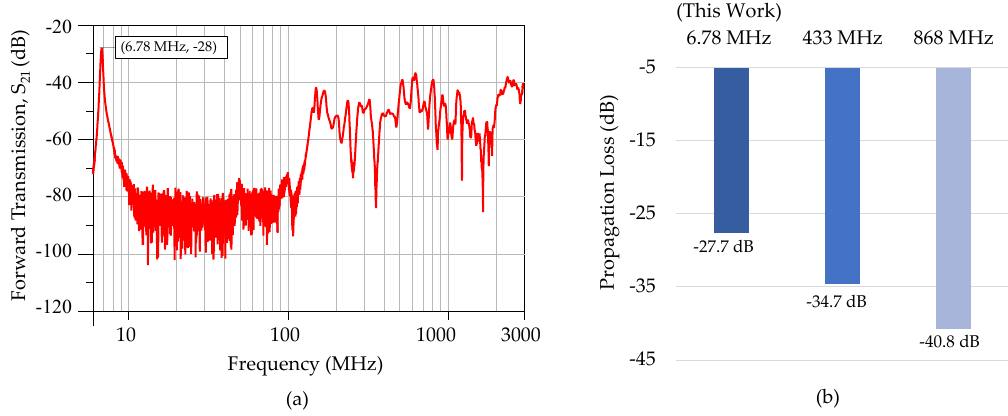
Figure 14. Comparison of the proposed near-field WPT technique with UHF ISM-bands: ( a ) measured S 21 from 5 MHz up to 3 GHz at 1-m coil separation, showing the highest WPT efficiency at 6.78 MHz due to the immunity to propagation losses. ( b ) Comparison of the measured S 21 with the free-space losses at 433 and 868